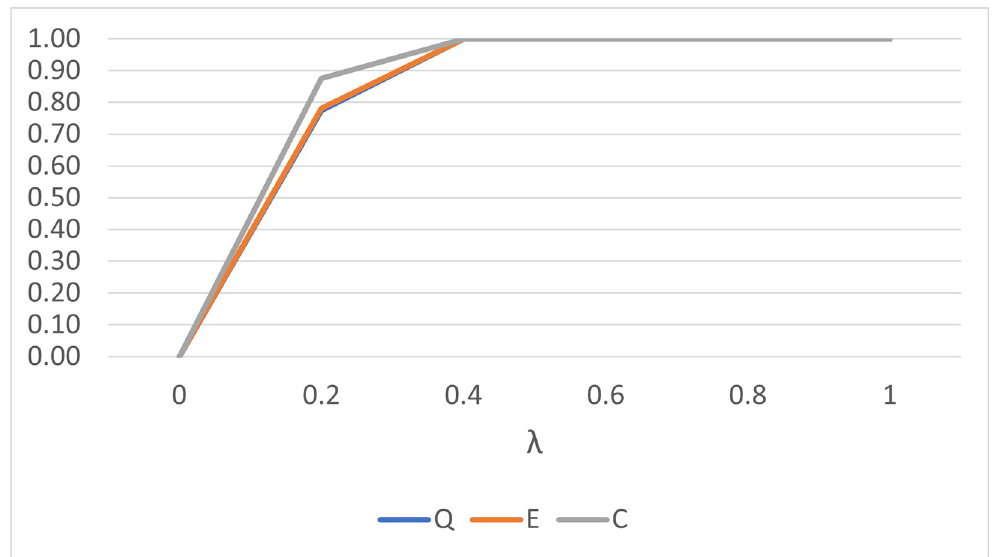
Fig 2. The performance of the Q k , E k and C k statistics for n = 30 and κ = 50 for a single outlier.